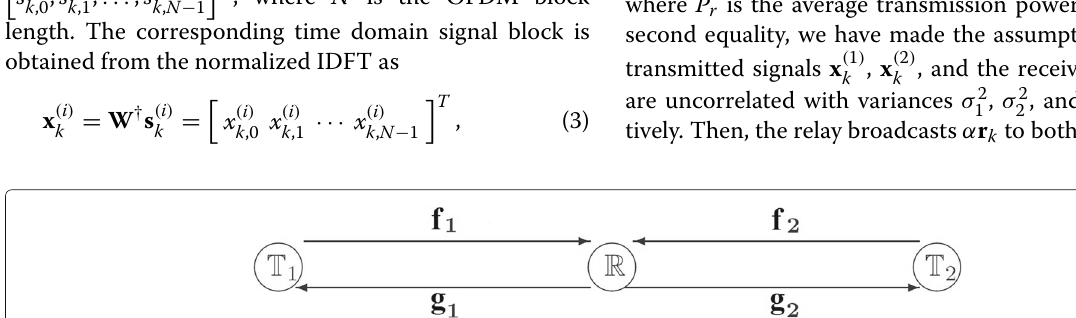
Fig. 1 System configuration for two-way relay network. It shows a two-way relay network with two terminal nodes T 1 and T 2 , and one relay node R . Each node has one antenna which cannot transmit and receive simultaneously. The channel from T = 1 and R back to T i is denoted as g i for i